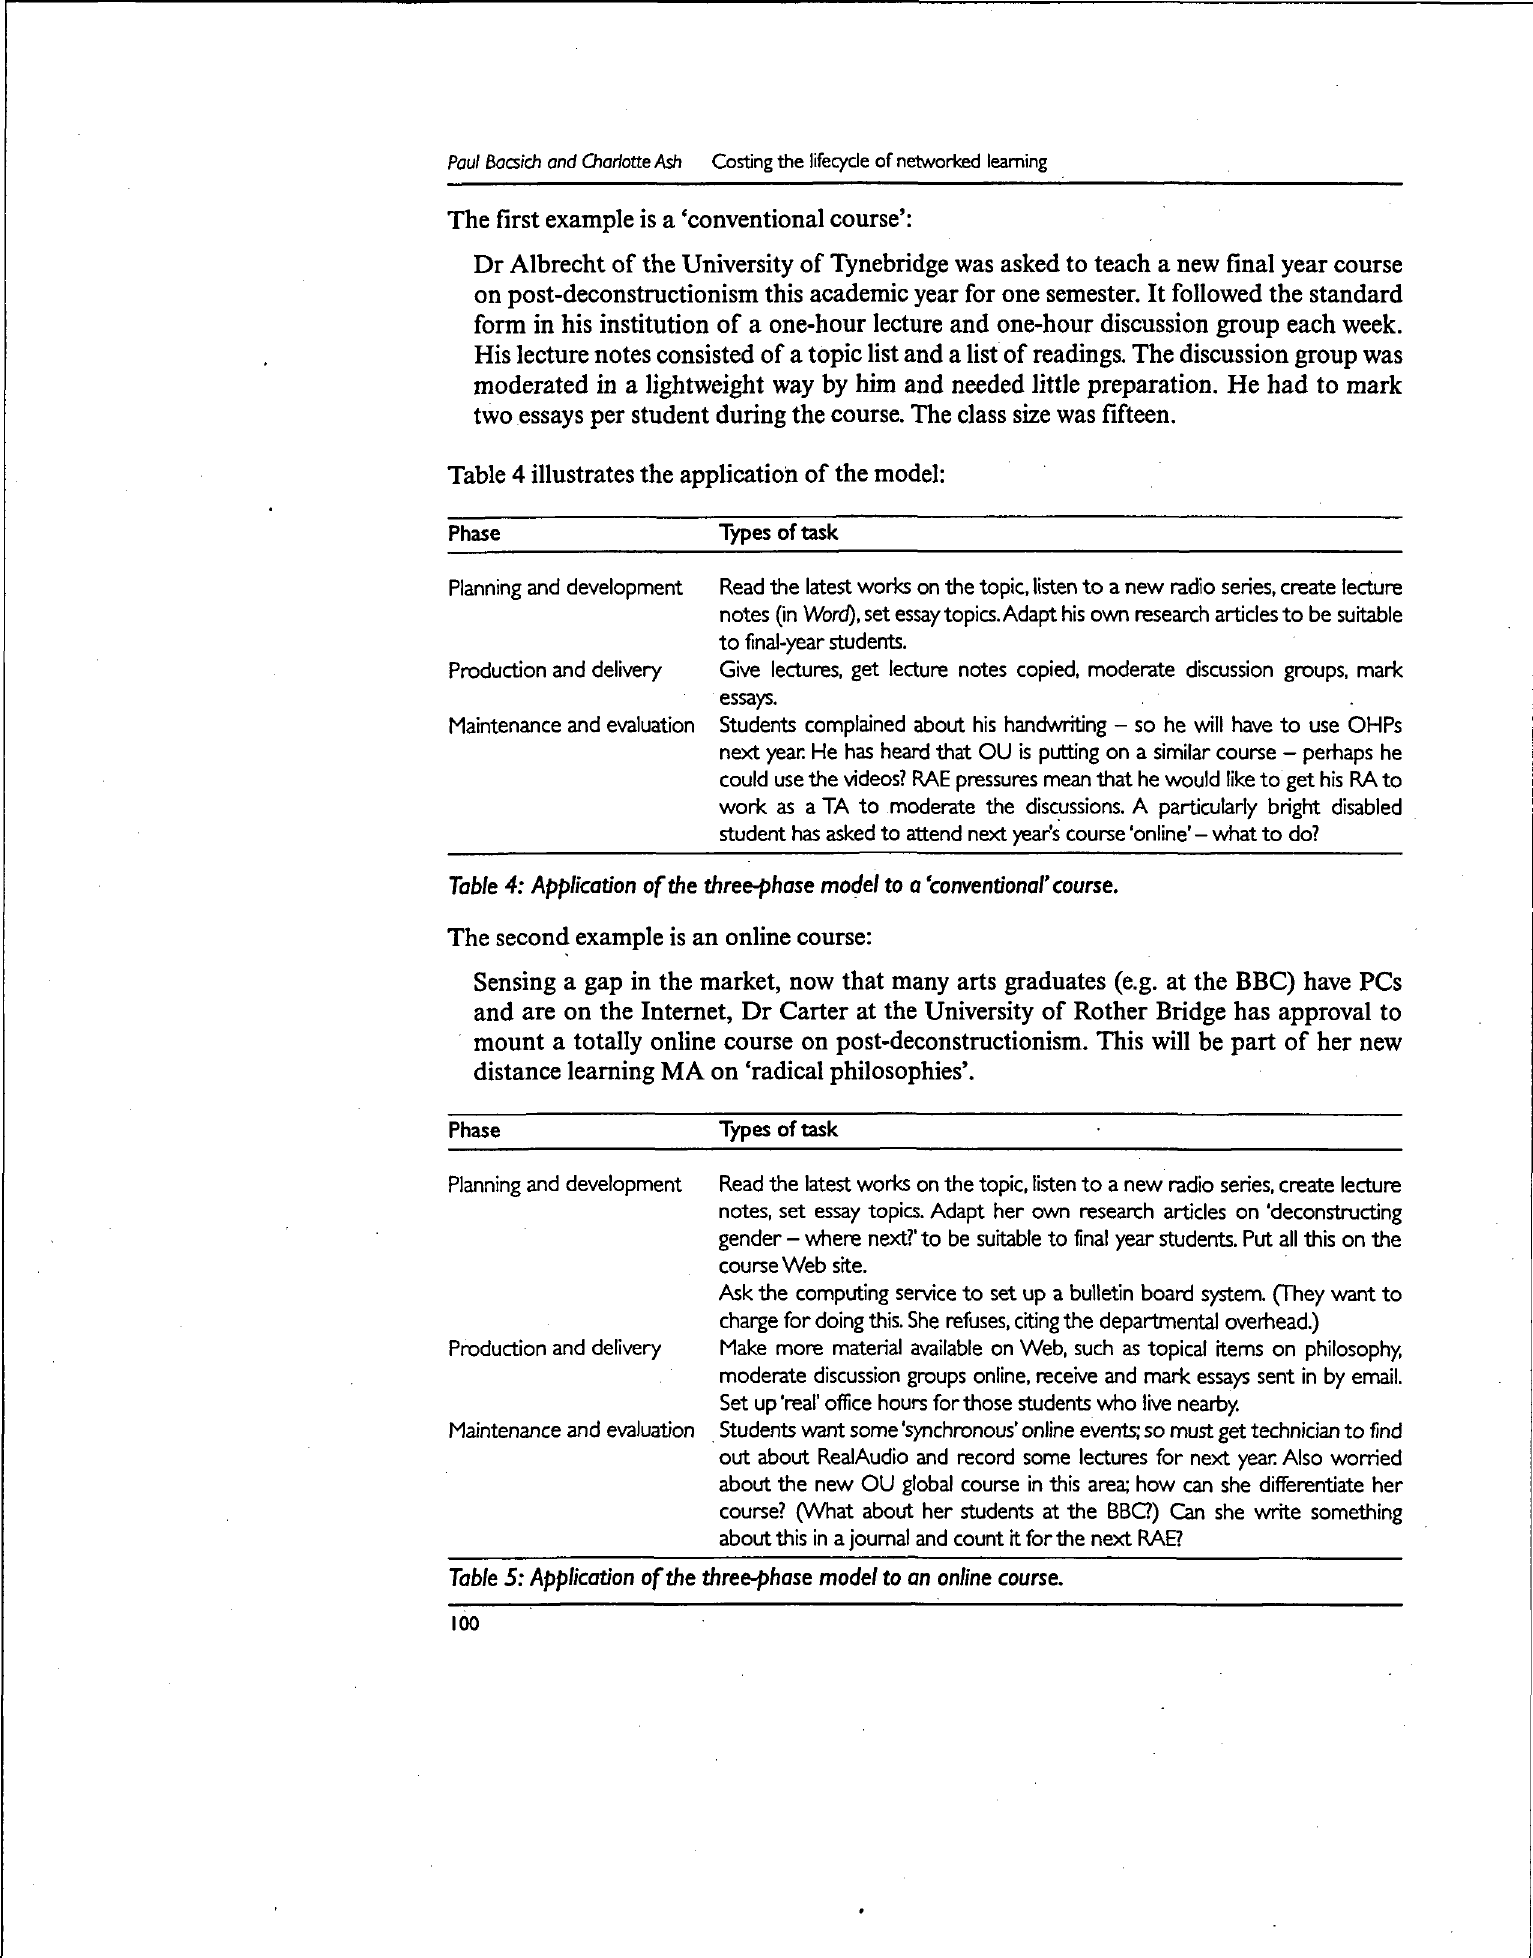
Table 5: Application of the three-phase model to an online